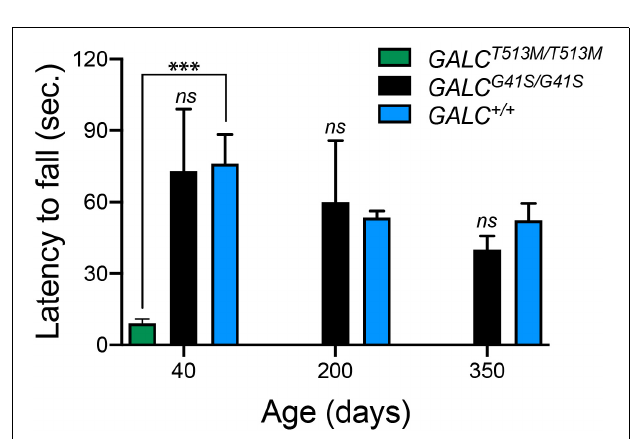
FIGURE 4 | GALC T 513 M / T 513 M but not GALC G 41 S / G 41 S mice exhibit rotarod deficits. Rotarod performance was significantly lower in GALC T 513 M / T 513 M mutants. Results are expressed as latency to fall in seconds (sec). Mice were tested at P40, P200, and P350. Data represent the mean + SEM of n = 6/group, analyzed by ANOVA/Tukey’s post hoc test ∗∗∗ p <